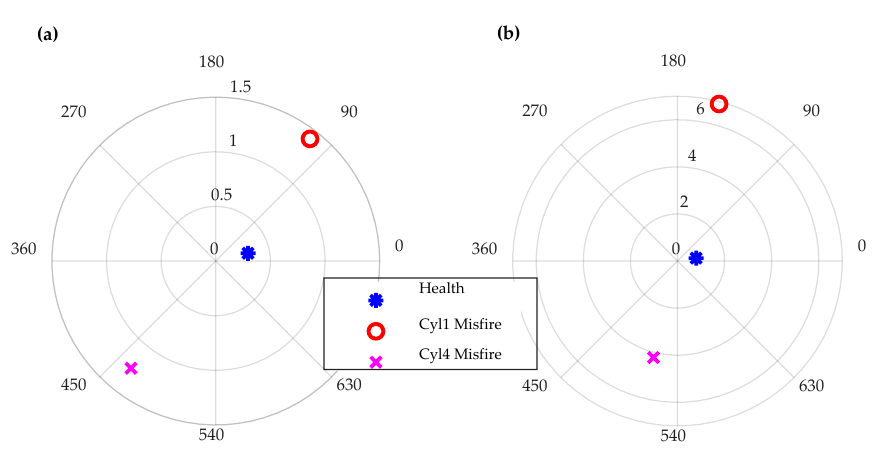
Figure 19. Polar plotting of the fault indicators at 1800 rpm and: ( a ) 0 Nm; ( b ) 105 Nm.